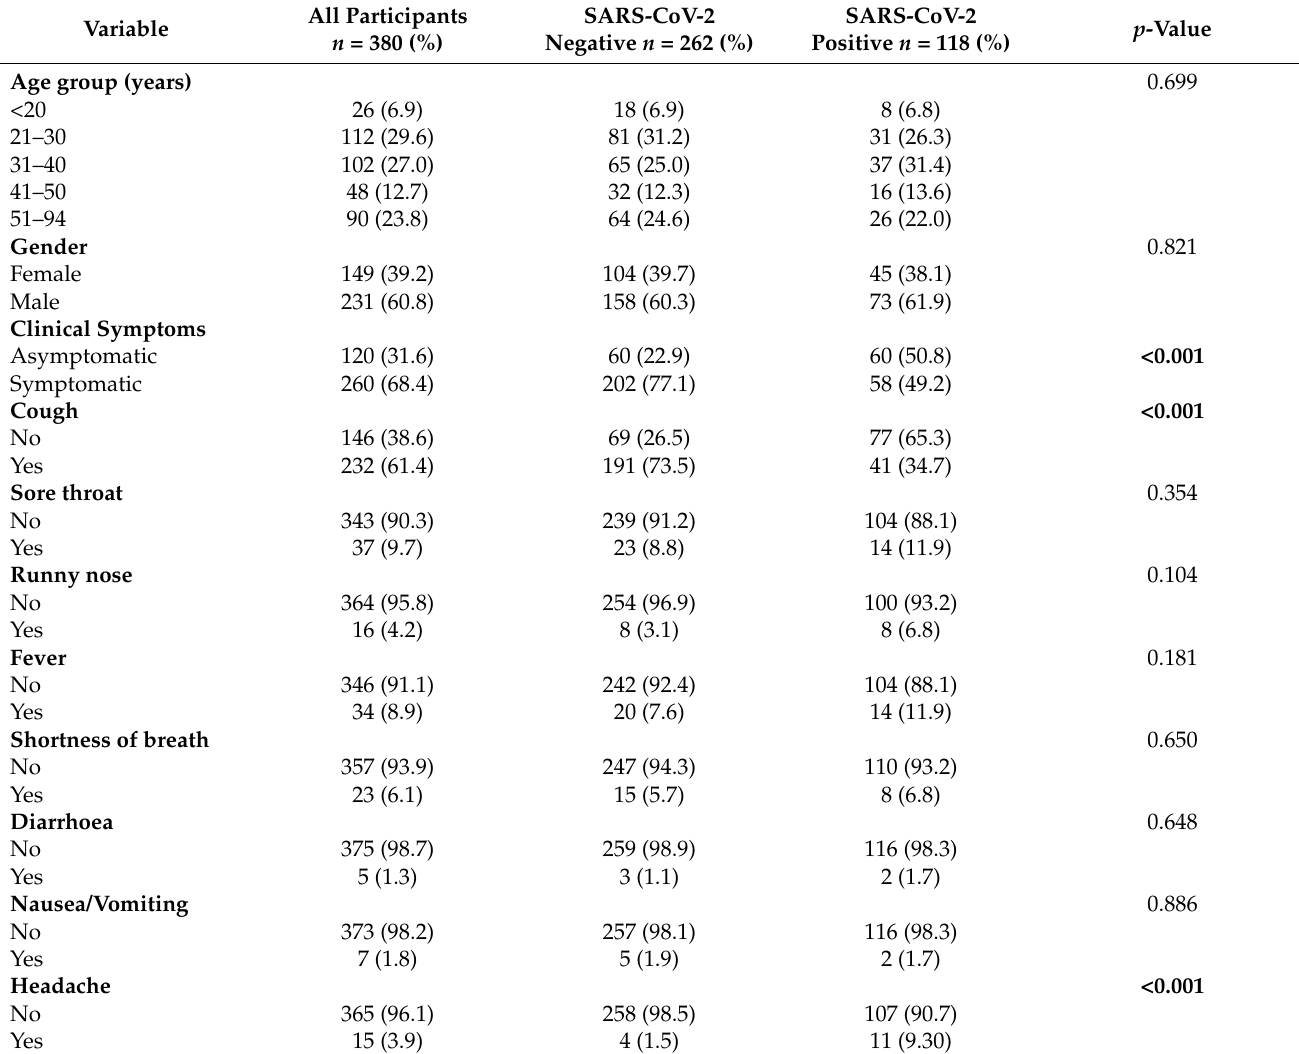
Table 1. Socio-demographic and clinical characteristics of study